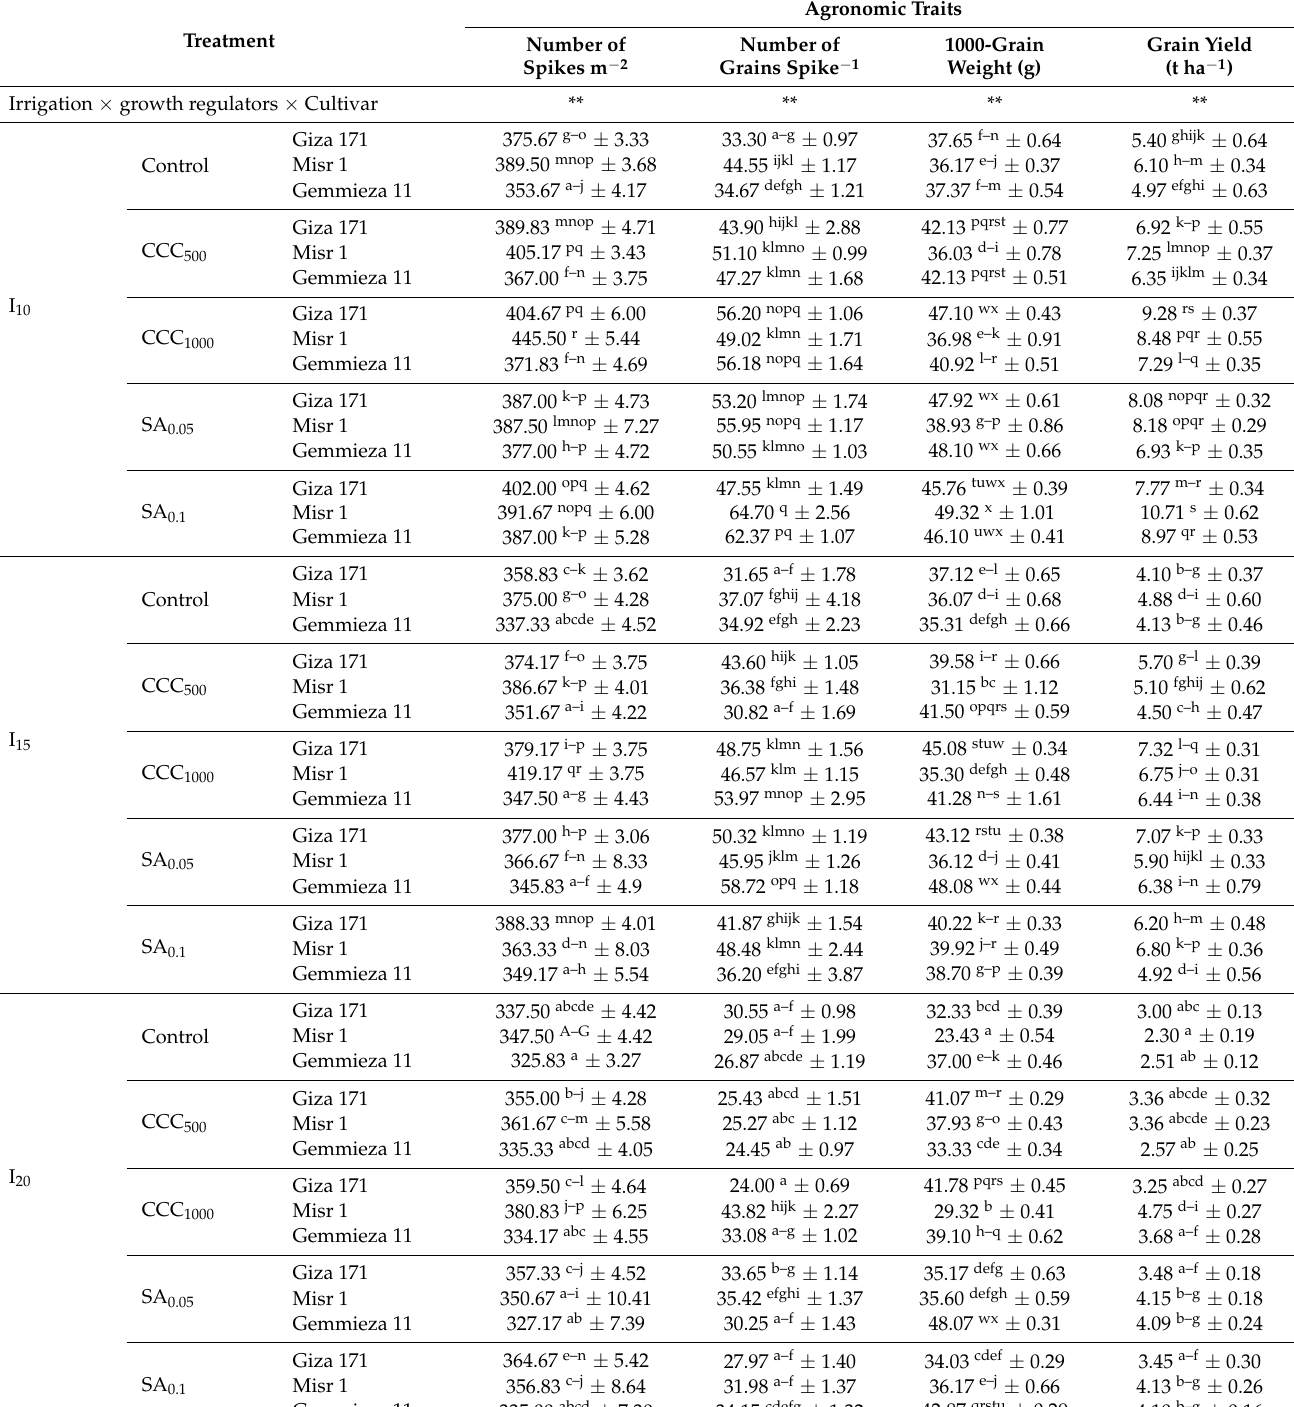
Table 6. Second-order interaction between irrigation intervals, growth regulators and wheat cultivars on number of spikes m − 2 , number of grains spike − 1 , 1000-grain weight (g), and grain yield (t ha − 1 ) of wheat in (combined two seasons) (mean ±